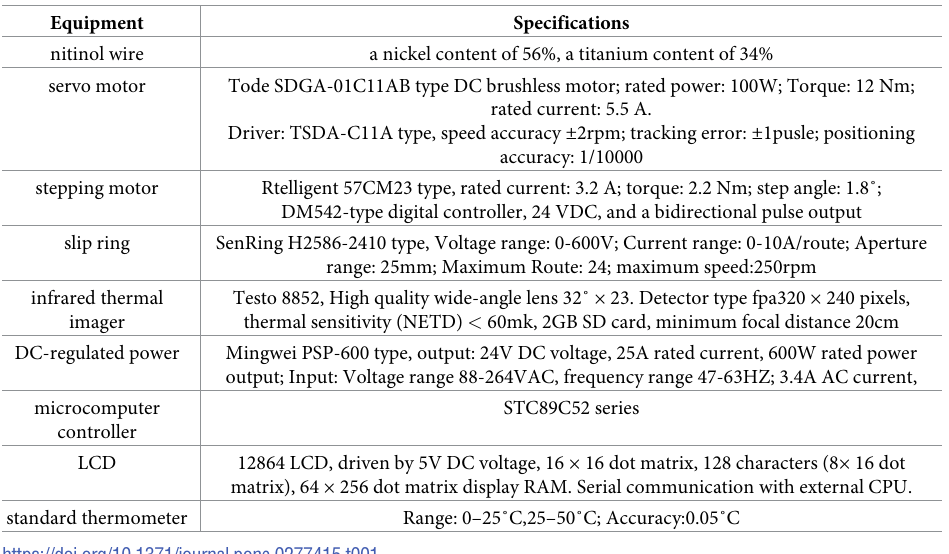
Table 1. Specifications of the